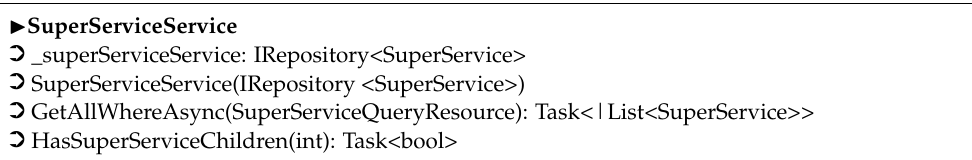
SuperServiceService.cs— examples of SuperService specific methods